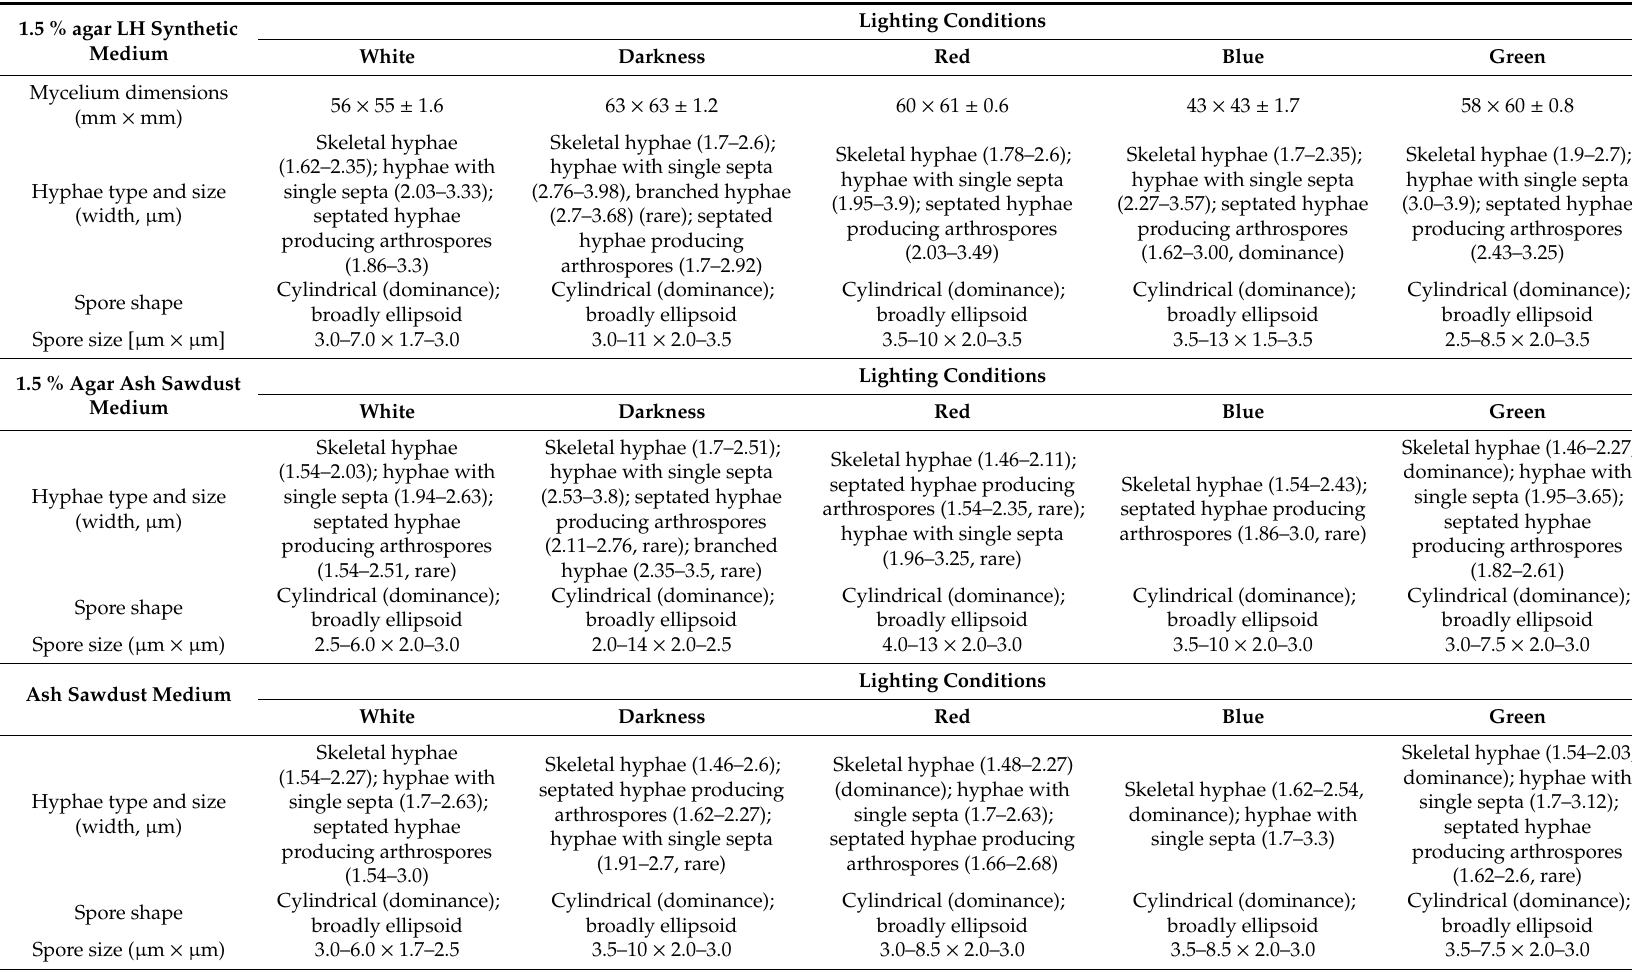
Table 1. Overall characteristics of Cerrena unicolor morphology observed in white, dark, red, blue, and green light conditions in di ff erent growth